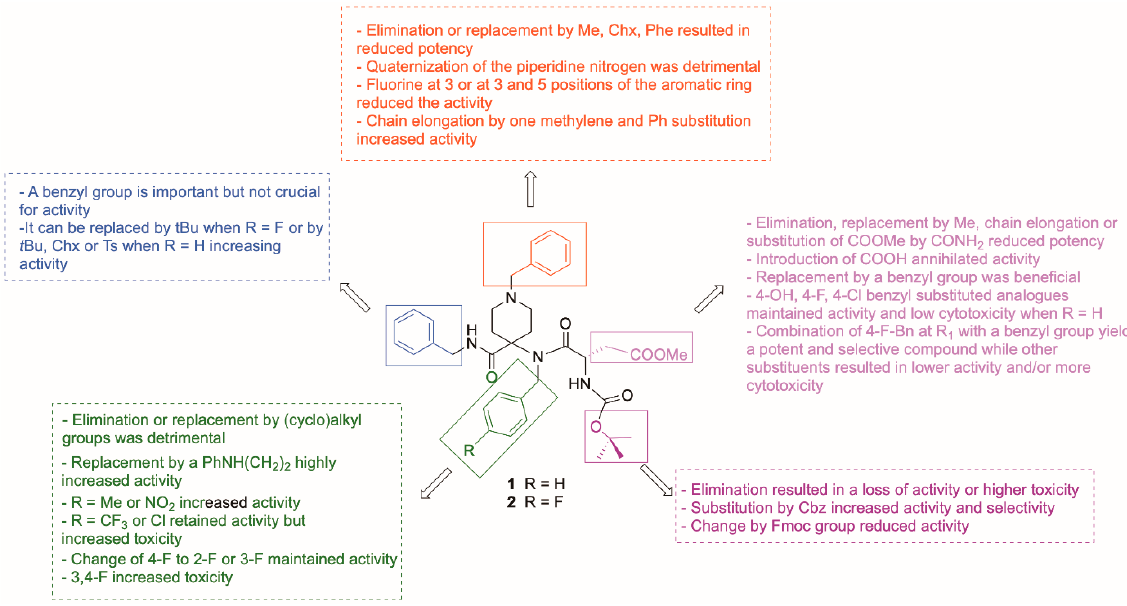
Figure 5. Current insights related to the SAR based on evaluation of compounds 1 – 63 against